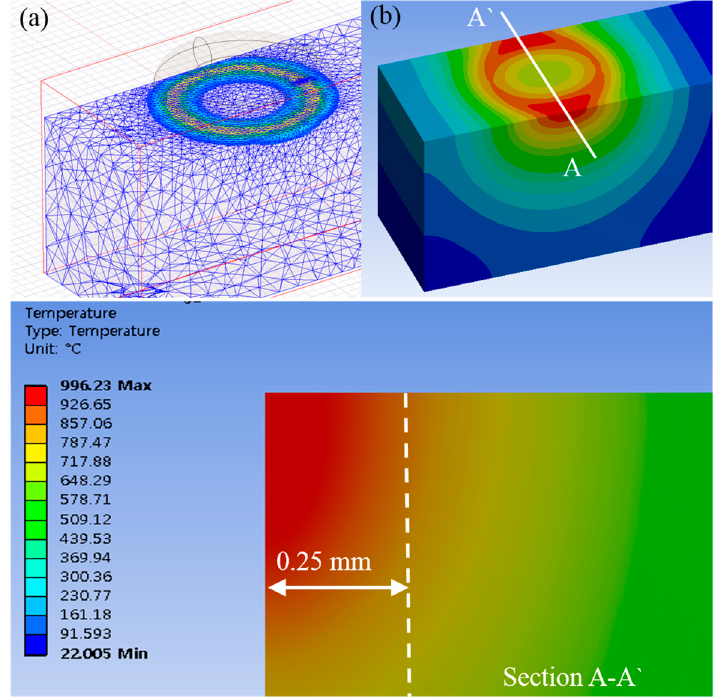
Figure 5. The results of finite element analysis; ( a ) electromagnetic, ( b ) thermal analysis.